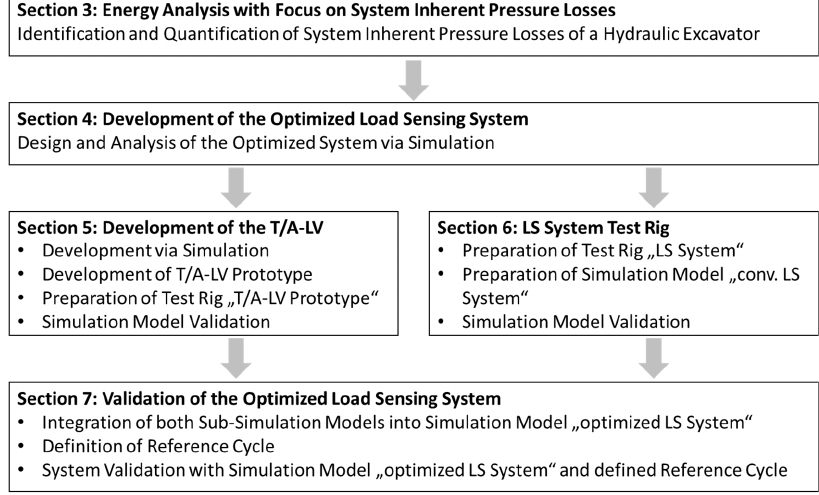
Figure 2. Flowchart of the research project.